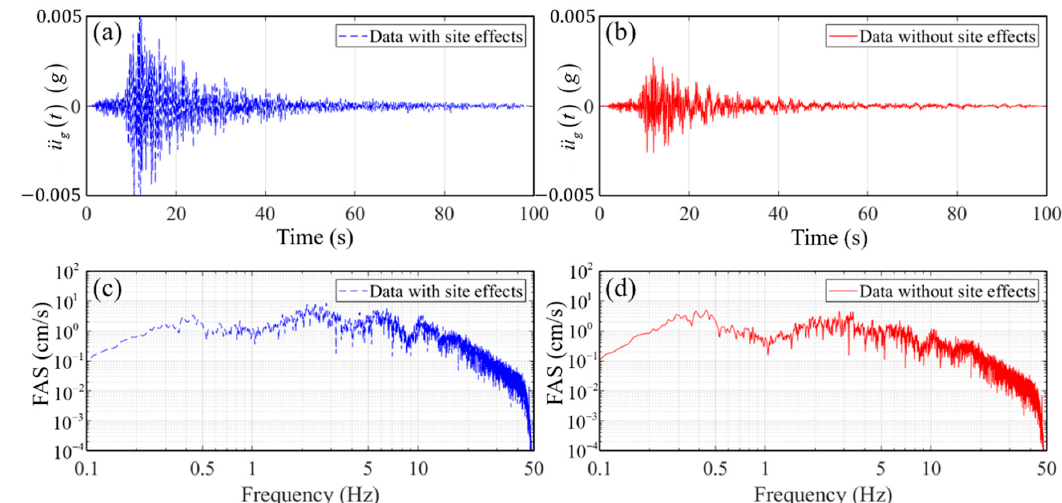
Figure 4. Ground motion recorded at station BUS2 with and without site effects: (a) Ground motion acceleration with site effects, (b) Ground motion acceleration without site effects, (c) Fourier amplitude spectrum with site effects, (d) Fourier amplitude spectrum without site effects.